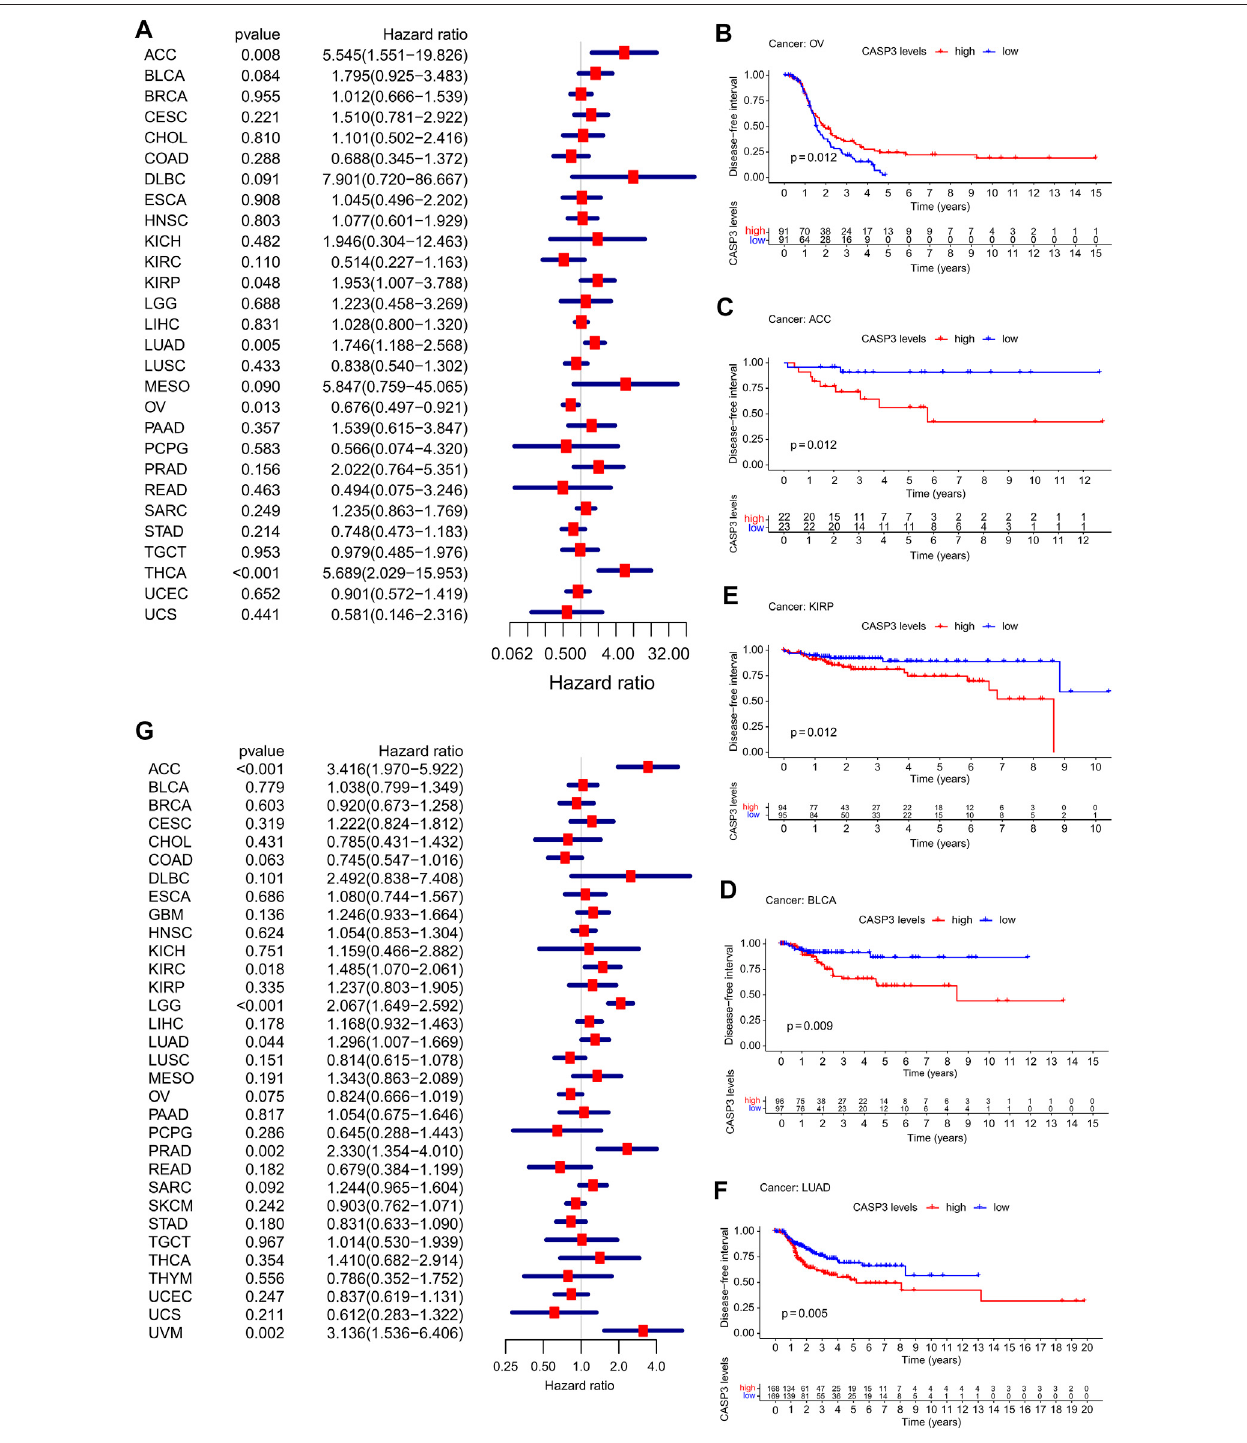
FIGURE4| Relationship between CASP3 expression and DFI,PFI, anddifferentpathological stages. (A) Expressionof CASP3 isassociatedwithDFI in33tumour types. (B – F) Kaplan-Meier survival analysis of the relationship between expression of CASP3 and DFI in speci fi c tumours. (G) Forest map of correlation between expressionof CASP3 andPFIin33tumourtypes. (H – O) Kaplan-Meiersurvivalanalysisoftherelationshipbetweentheexpressionof CASP3 andPFIinspeci fi ctumours. (P – S) Relationship between CASP3 levels and different pathological stages of COAD, SKCM, THCA, OV. Relationship between CASP3 expression and DFI, PFI, and different pathological stages (continuation of Figure 4